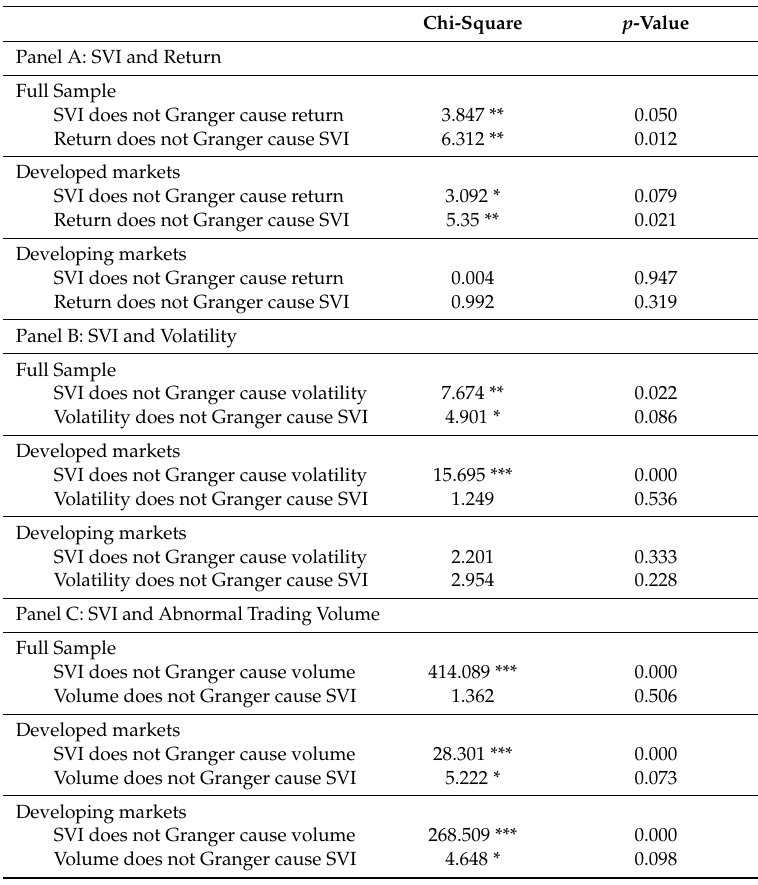
Table 1. Panel Granger